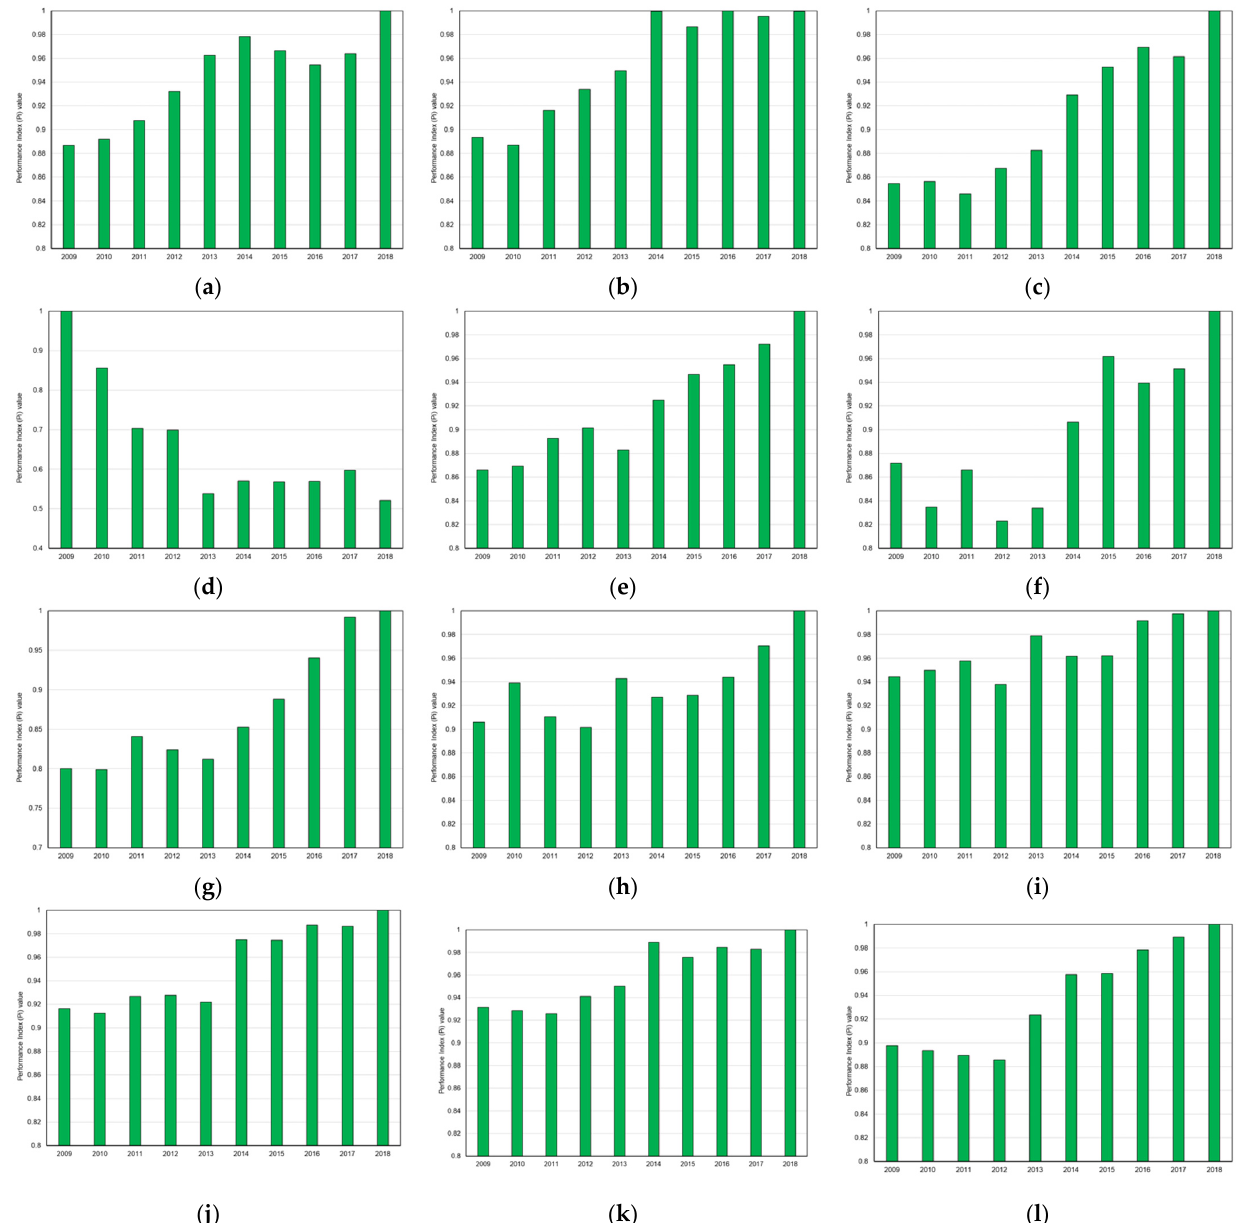
Figure 7. The value of the P i index of energy and climate sustainability in each EU country in the studied years ( a